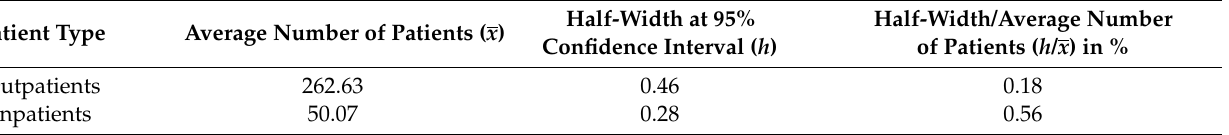
Table 5. Number of patients entering the system in 5 days after 30